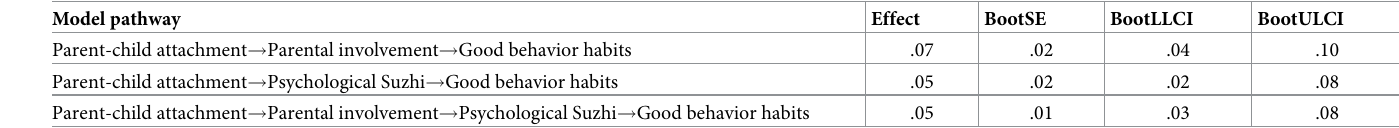
Table 2. Standardized indirect effects and 95% CIs for the mediational model (n = 563). Model